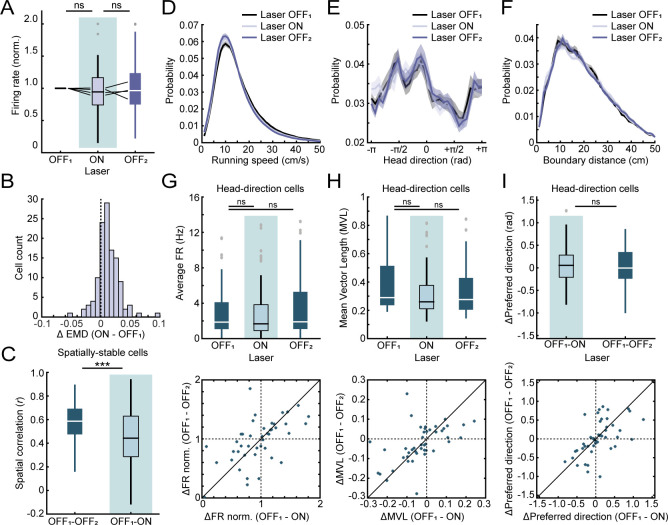
Additional analyses for optogenetic experiments.(A) Optogenetic inactivation of MEC neurons that project to RSC had no effect on border cell firing rates in RSC. Black lines indicate individual animals. (B) Distribution of changes in EMD scores in RSC border cells between ratemaps of the laser OFF and ON session, showing a positive shift in scores across the population of neurons during optogenetic inhibition of MEC input. (C) Spatially-stable cells in RSC (n = 83 spatial cells), classified with spatial correlations between rate maps of both laser OFF sessions above the 99th percentile of a shuffled distribution that were not border cells, were affected by inhibition of MEC, leading to lower spatial correlations with laser light on. (D-F) Inhibition of MEC did not result in any observable changes in the animal’s behavior, with no changes in the running speed (D), head-direction (E) nor distance to the nearest boundary (F). (G-I) Cells tuned to allocentric head-direction were present in both MEC and RSC, but inhibition of MEC neurons had no effect on head-direction tuning of HD cells in RSC (n = 47 head-direction cells). There was no change in average firing rates (G), tuning strength expressed as MVL (H), nor a shift in the preferred direction of the cell’s tuning curve (I). ***p<0.001, Wilcoxon signed-rank test.